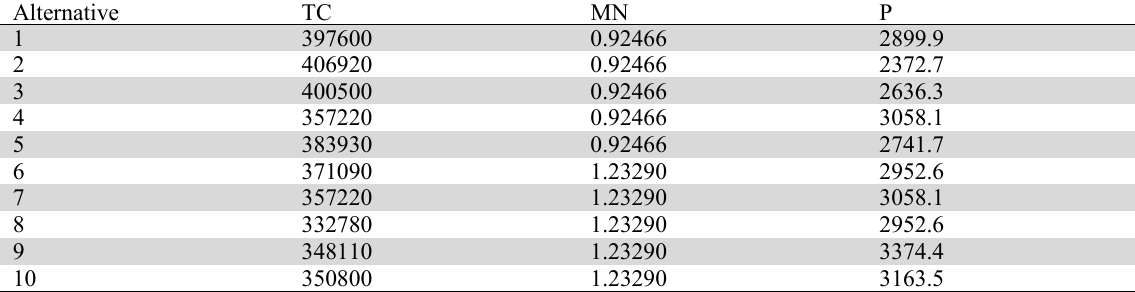
The root-weighted decision